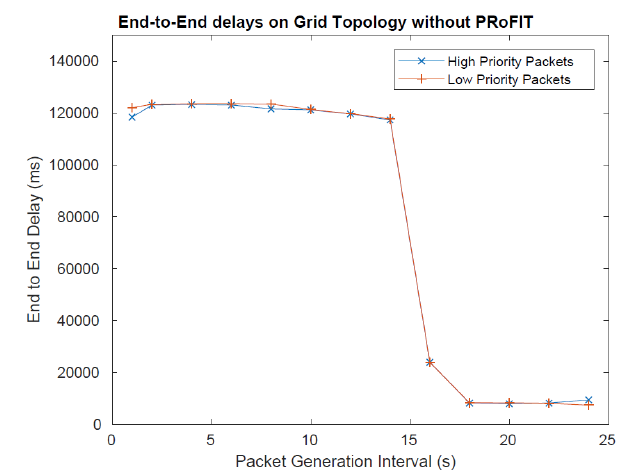
Figure 7 . End-to-End Delays on Grid Topology without PRoFIT